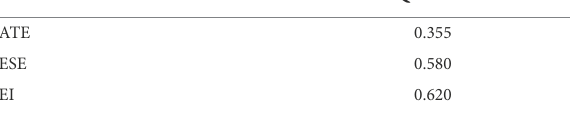
TABLE 10 Predictive relevance (Q 2